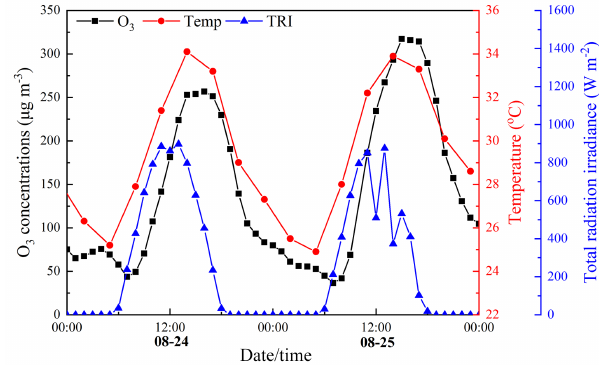
Figure 2. Time series of surface O 3 concentrations (O 3 ), 2m air temperature (Temp) and surface total radiation irradiance (TRI) ob- served at the NJ site.